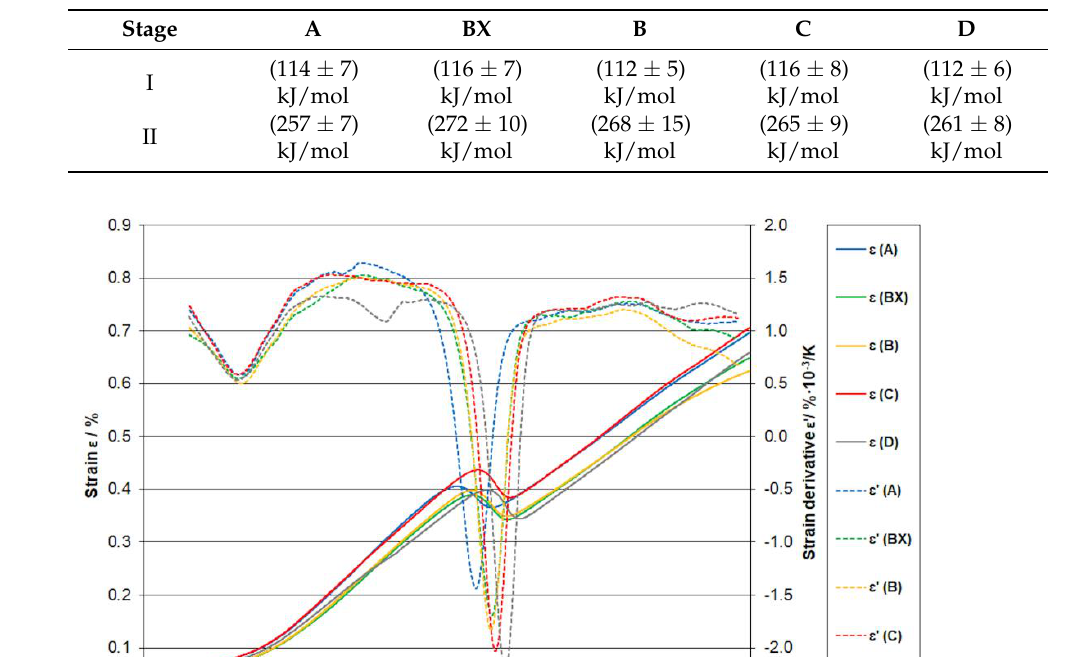
Table 4. Activation energy E of formation transition carbides in Stage I and cementite in Stage II calculated for the steels A, BX, B, C, and D, using Equation (4).